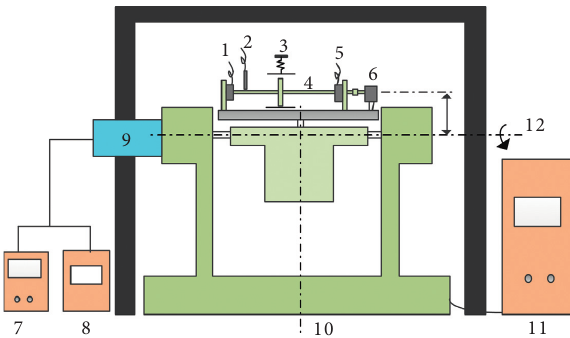
Figure 18: Schematic diagram of the experimental device. 1, rotary encoder, 2, displacement sensors, 3, rub-impact device, 4, rotor system, 5, rotary encoder, 6, motor, 7, rotor control system, 8, data acquisition system, 9, slip ring, 10, base motion platform, 11, base motion platform control system, 12, rolling